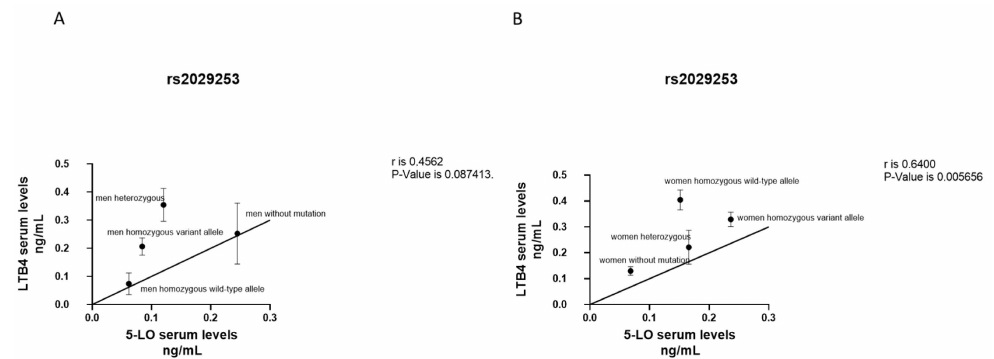
Figure 3. Correlation between LTB4 and 5-LO serum levels according to genotype ALOX5 rs2029253 polymorphism in M ( A ) and W ( B ). Results were shown as means ± SEM. The statistical test used in these analyses was the Pearson correlation test considering 95% confidence interval.